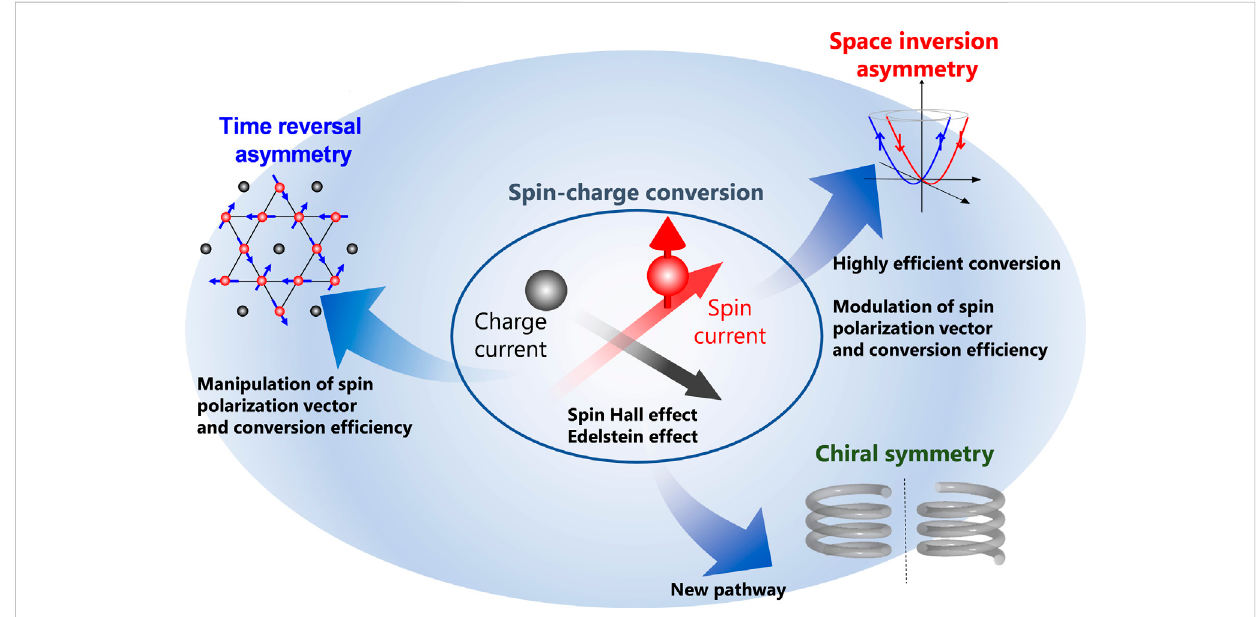
FIGURE 2 Explore spin – charge conversion functionality by focusing on spatial asymmetry, time-reversal asymmetry, and chiral